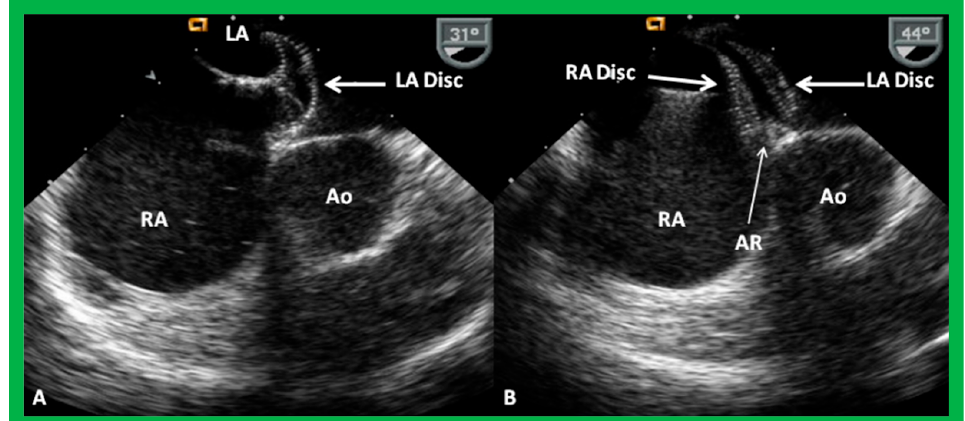
Figure 27. Transesophageal echocardiographic images during the delivery of an Amplatzer Septal Occluder. ( A ). The left atrial disc (LA Disc) (thick arrow) was delivered into the left atrium (LA). ( B ). Both the LA and right atrial (RA) discs (thick arrows) were delivered across the atrial septal defect. It is clearly seen that the aortic rim (AR) (thin arrow in ( B )) is sandwiched in-between the LA Disc and RA Disc. Ao, aorta. Reproduced from Reference [7].